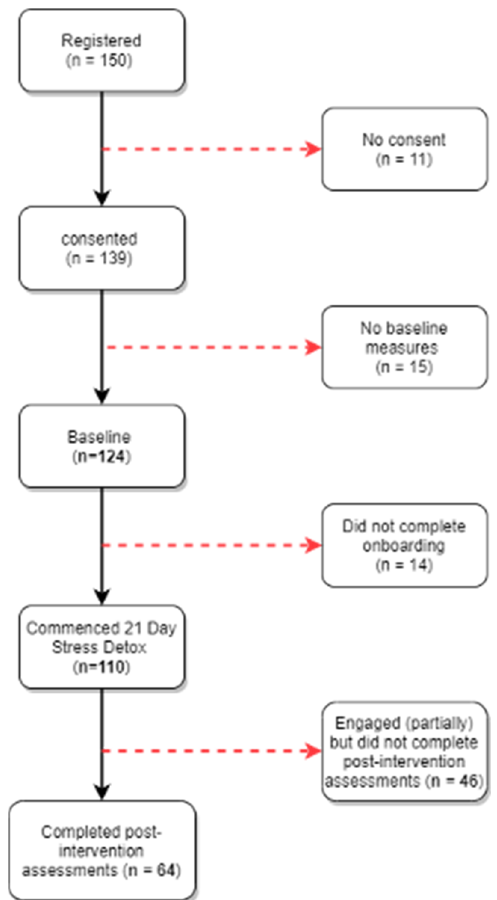
Figure 3. Flowchart of the participants through the